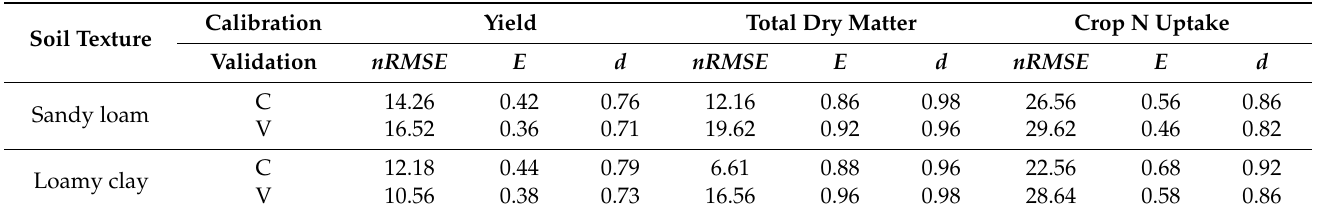
Table 1. Statistical criteria for simulation of total dry matter, yield, and crop N uptake.